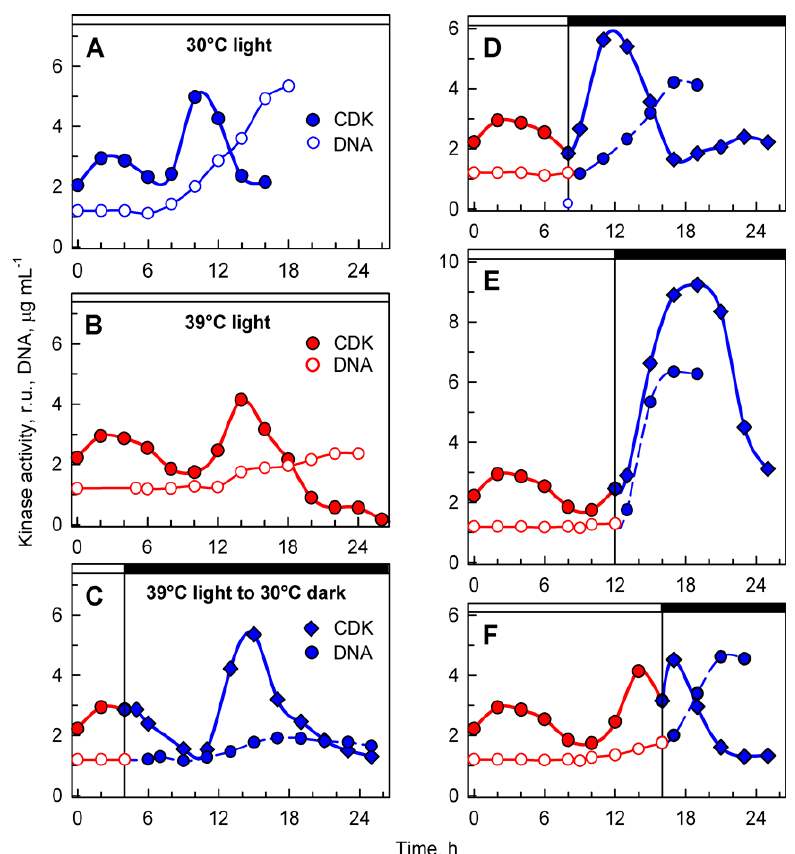
Figure 7. Activity of cyclin-dependent kinase (CDK) in whole-cell lysates prepared from synchronized cultures of Chlamydomonas reinhardtii cultivated under different light and temperature conditions. Panels A, B , the cells were grown in continuous light at 30 °C ( A ) or 39 °C ( B ); panels C– F , the cells were grown at 39 °C and then placed into the dark after 4, 8, 12, and 16 h and kept at 30 °C. Solid blue lines, full circles, kinase activity in cultures grown in continuous light at 30 °C; solid red lines, full circles, kinase activity in cultures grown in continuous light at 39 °C; solid blue lines, diamonds, kinase activity in cultures transferred from light at 39 °C to darkness at 30 °C. Solid blue lines, empty circles, DNA content in cells grown at 30 °C; solid red lines, empty circles, DNA content in cells grown at 39 °C; dashed blue lines, full circles, DNA content in cells transferred from 39 to 30 °C. Times of transfer into darkness are indicted by vertical lines and by dark boxes above the graphs.